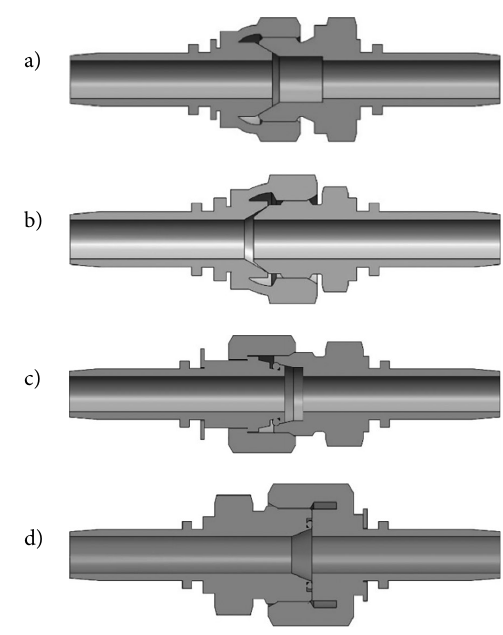
Figure 3. Cross-section standards of 3D model fitting